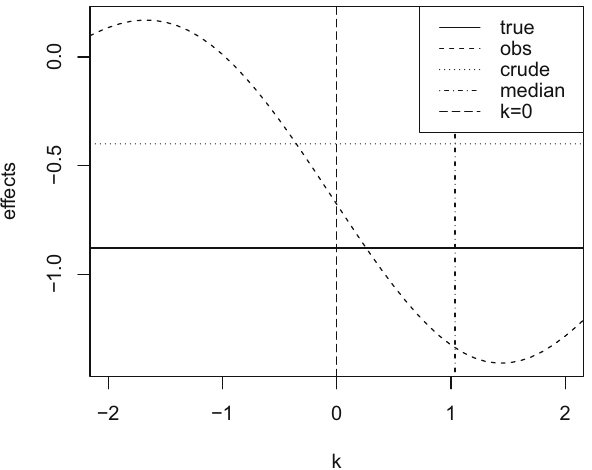
, μ 2 , β 0 = , γ 1 = , 0 = 1 =